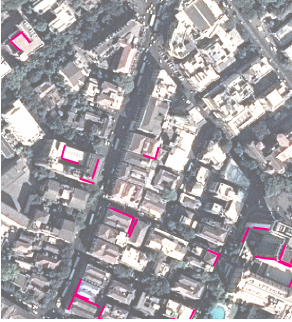
Figure 5. Line segment